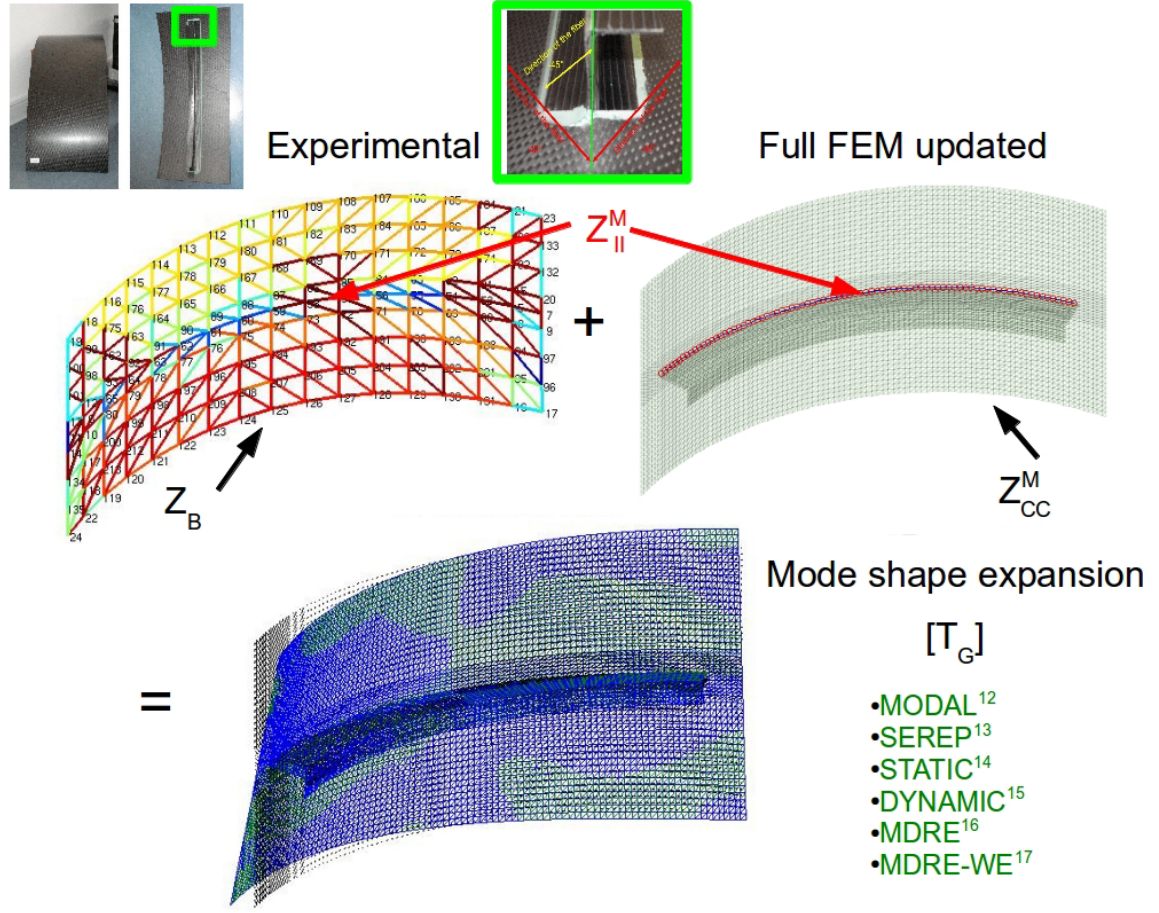
Figure 2: MSE process plot.